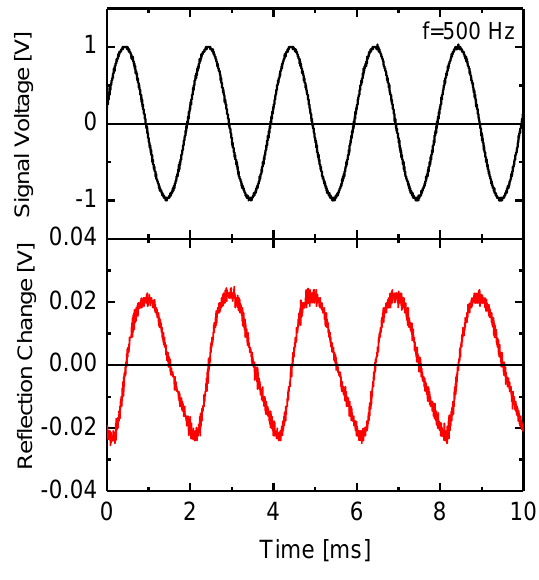
Figure 6. Input signal to the piezo driver for vibration operation at f = 500 Hz (the upper figures) and the measured intensity change of light reflected from the microcavity (the lower